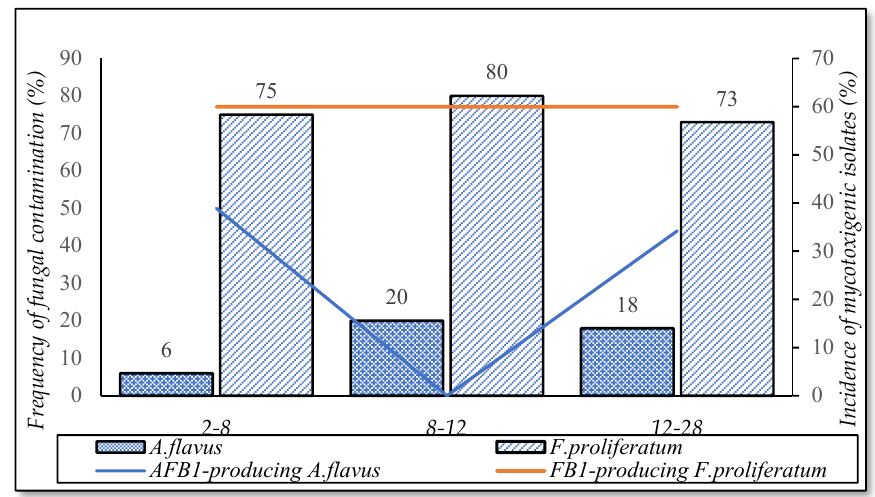
Figure 10. Incidence of fungal contamination and mycotoxigenic fungi in function of delayed drying times.